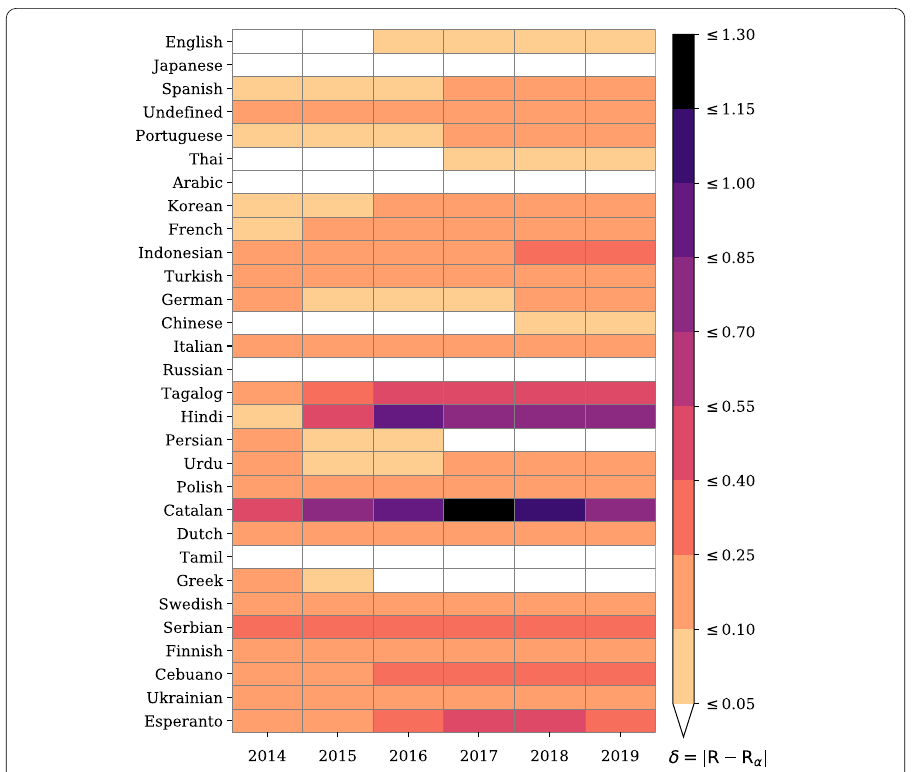
Figure 10 Margin of error for contagion ratios. We compute the annual average of contagion ratios R for all messages in the top 30 ranked languages as classified by FastText-LID and described in Sect. 3.3. Similarly, we compute the annual average of contagion ratios R α for the subset of messages that both classifiers have unanimously labeled their language labels. We display the absolute difference δ = | R – R α | to indicate our margin of error for estimating contagion ratios as a function of the agreement between FastText-LID and Twitter-LID models. White cells indicate that δ is below 0.05, whereas colored cells highlight values that are equal to, or above 0.05. We show the top 10 languages with the highest average values of δ ’s per year in Table 4. We also show the bottom 10 languages with the lowest average values of δ ’s per year in Table